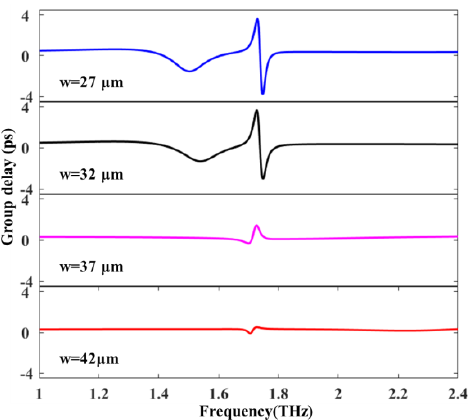
Figure 8. The group delay of the hybrid metamaterial with different widths of the graphene strip.